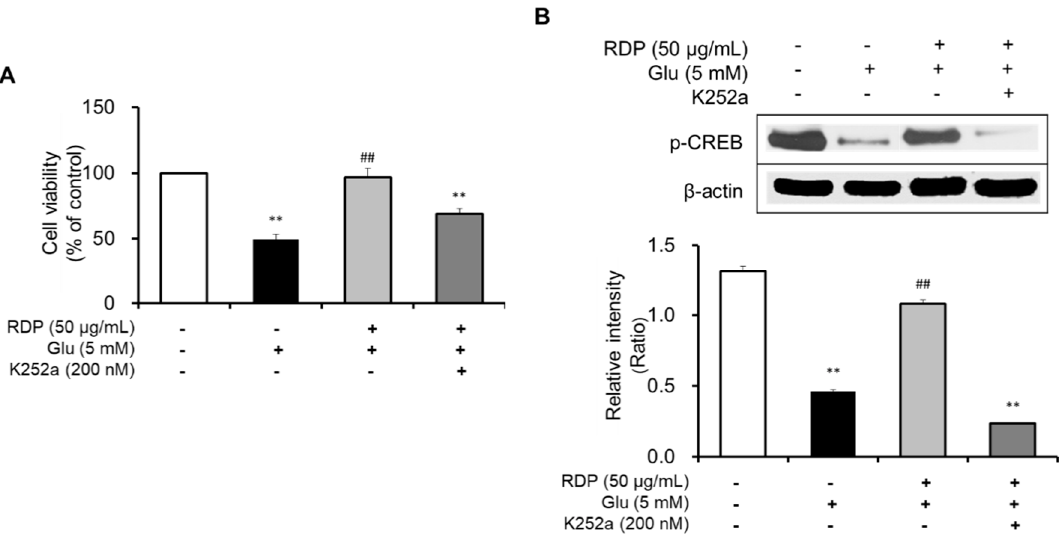
Figure 8. Inhibitory effect of K252a on the neuroprotective effect of ethyl acetate extract of Ribes diacanthum Pall (RDP). The experiments were performed as described in the Materials and Methods. The data were obtained from three independent experiments. ( A ) Cell viability, and ( B ) cAMP-calcium response element-binding protein (p-CREB) and β -actin. ** p < 0.01 versus glutamate 5 mM + RDP 50 µ g / mL group. ## p < 0.01 versus glutamate-treated group–indicates absence, + indicates presence.